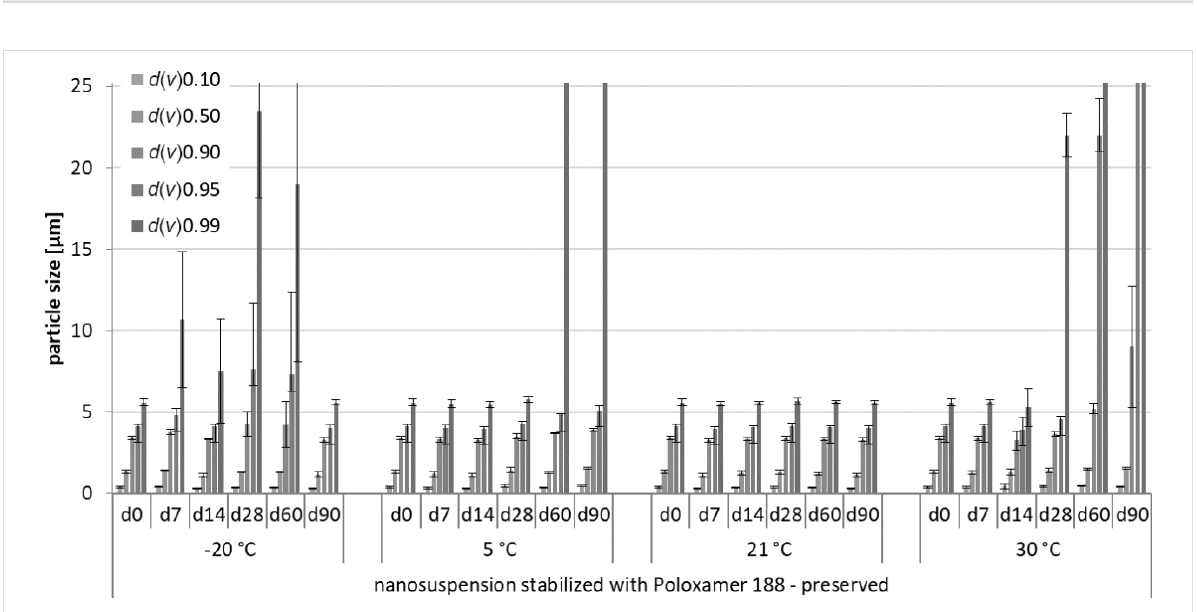
Figure 4: Physical stability during three months of storage at different storage temperatures for the preserved nanosuspensions stabilized with Polox- amer 188 (LD